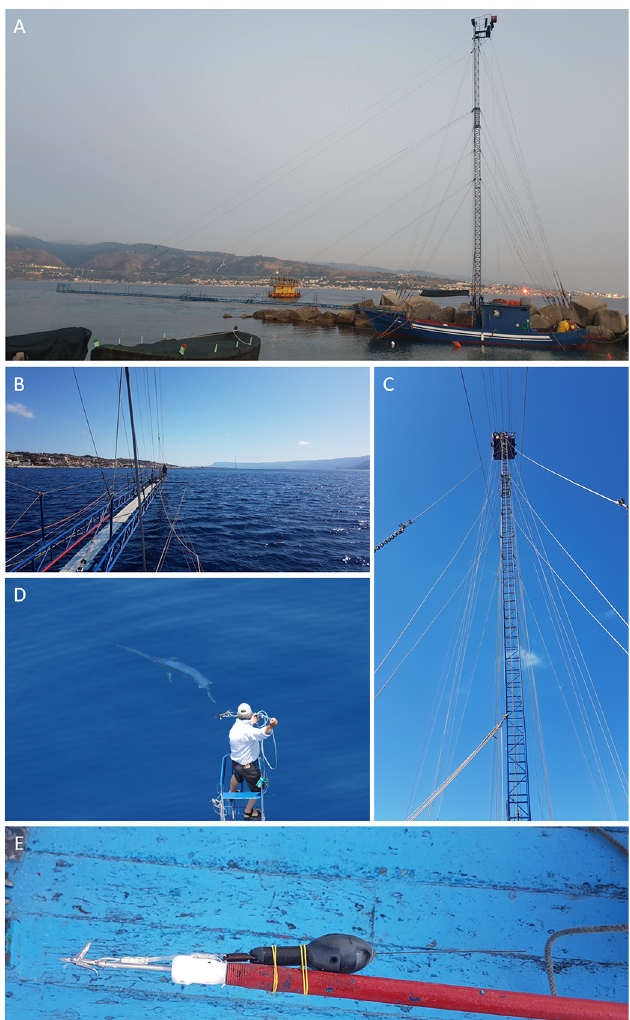
Fig. 2. Harpoon vessel and equipment used for the tagging experiment. ‘ Feluca ’ boat (a), plank (b), ‘ must ’ (c) harpooner during fi shing operations (d) and modi fi ed harpoon consisting in a 3.5m pole equipped with the pop-up satellite archival tag